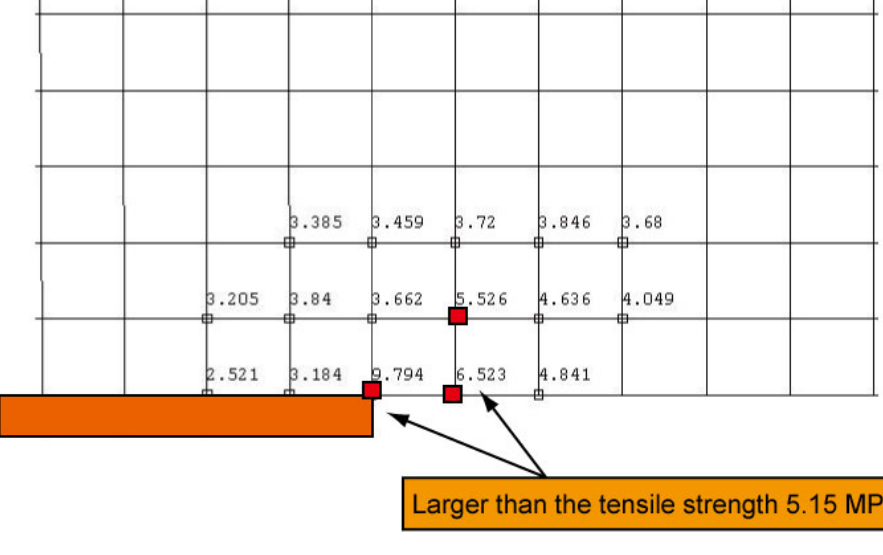
Figure 15. The specific value around the region at the end of the